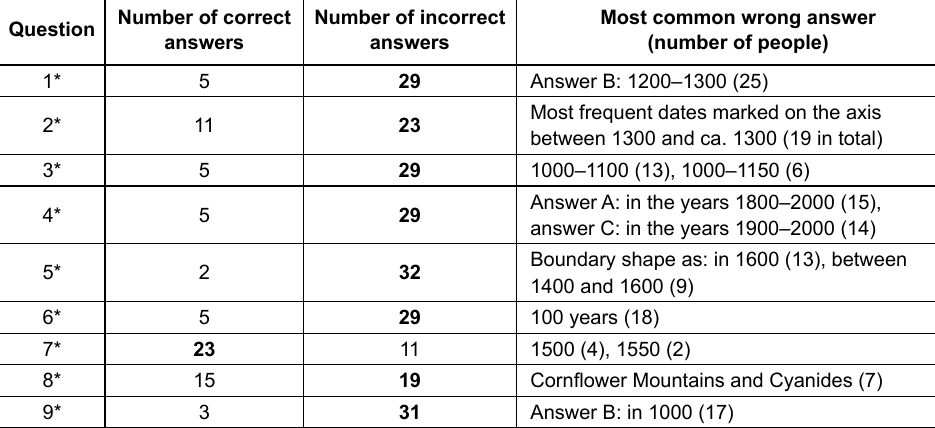
Table 2. The analysis results for responses of G1 respondents Number of correct Question